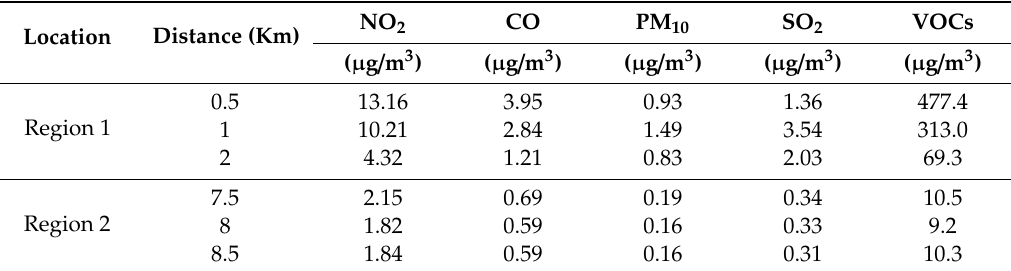
Table 2. Average concentrations of NO 2 , CO, PM 10 , SO 2 , and VOCs obtained via the simulated plume